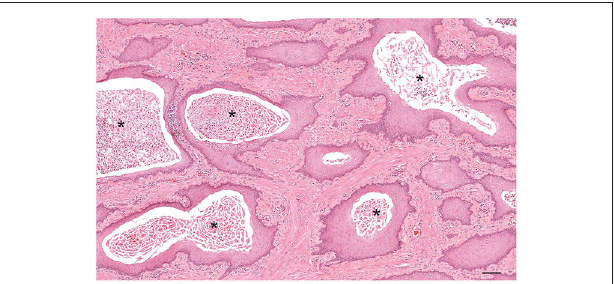
FIGURE 10 | Histology of squamous metaplasia in a dog with Sertoli cell tumor. The glandular alveoli are lined by a pluristratified squamous epithelium with intraluminal accumulation of keratin squames and sloughed epithelial cells (asterisks). Hematoxylin-eosin staining. Bar = 200 µ